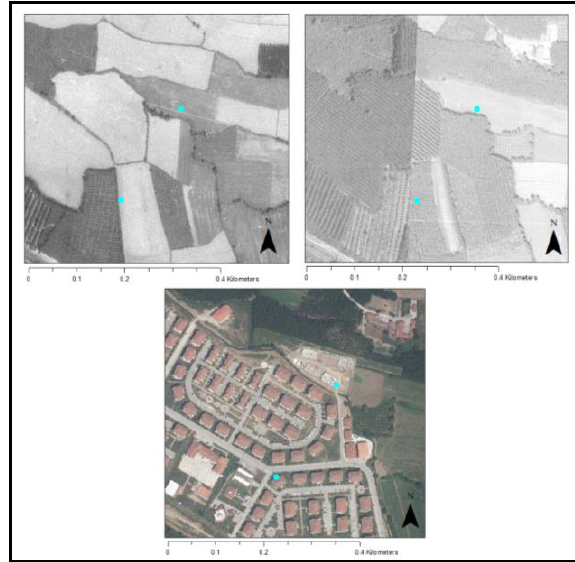
Figure 2 . Example of canopy cover transition for the periods (1984 -upper left, 1999 -upper right, and 2015 -bottom) In some respect, the use of aerial photographs with a random sampling approach for urban tree canopy cover assessment offers a relatively accurate, cost and time-effective alternative compared to the traditional ground sampling approach. However, it may be challenging to interpret urban trees on vertical imagery due to spectral separability between trees and near features, shadows of the crown, and other objects. In addition, the factors, including combined effects